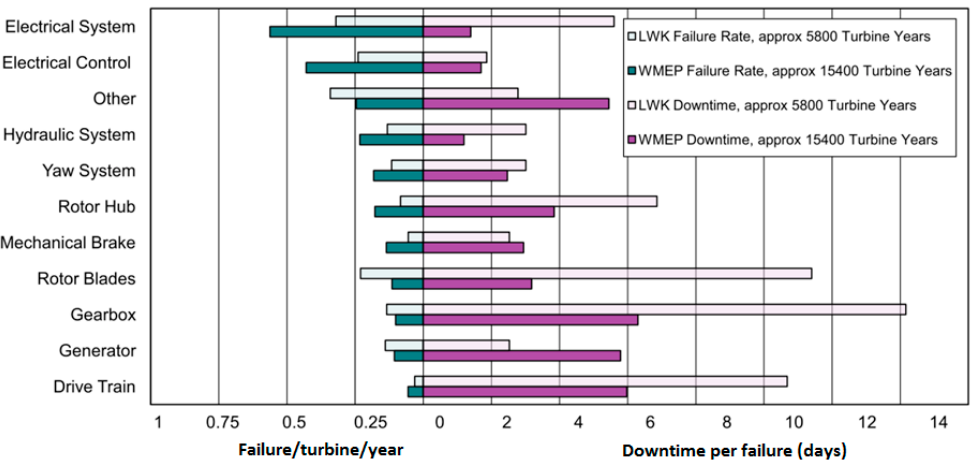
Figure 4. Failure per turbine per year and downtime from two large surveys of European onshore wind turbines over 13 years (LWK and WMEP).